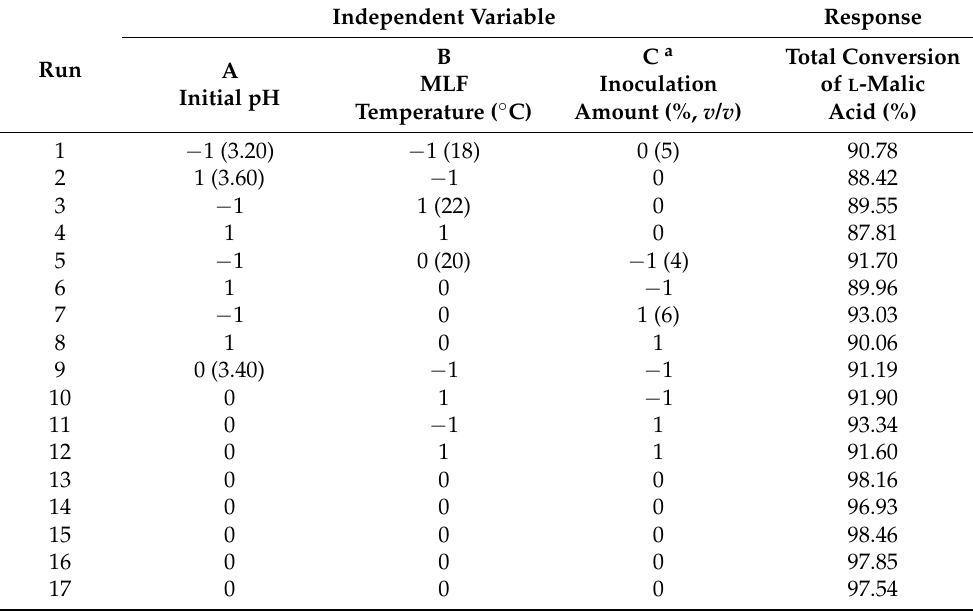
Table 1. Box–Behnken design and response values for MLF-treated pear–kiwifruit wine.